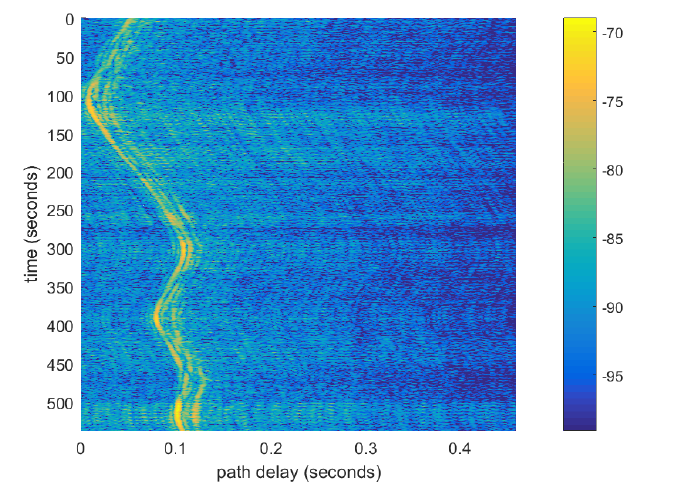
Figure 11. Channel impulse response as a function of time for the long range